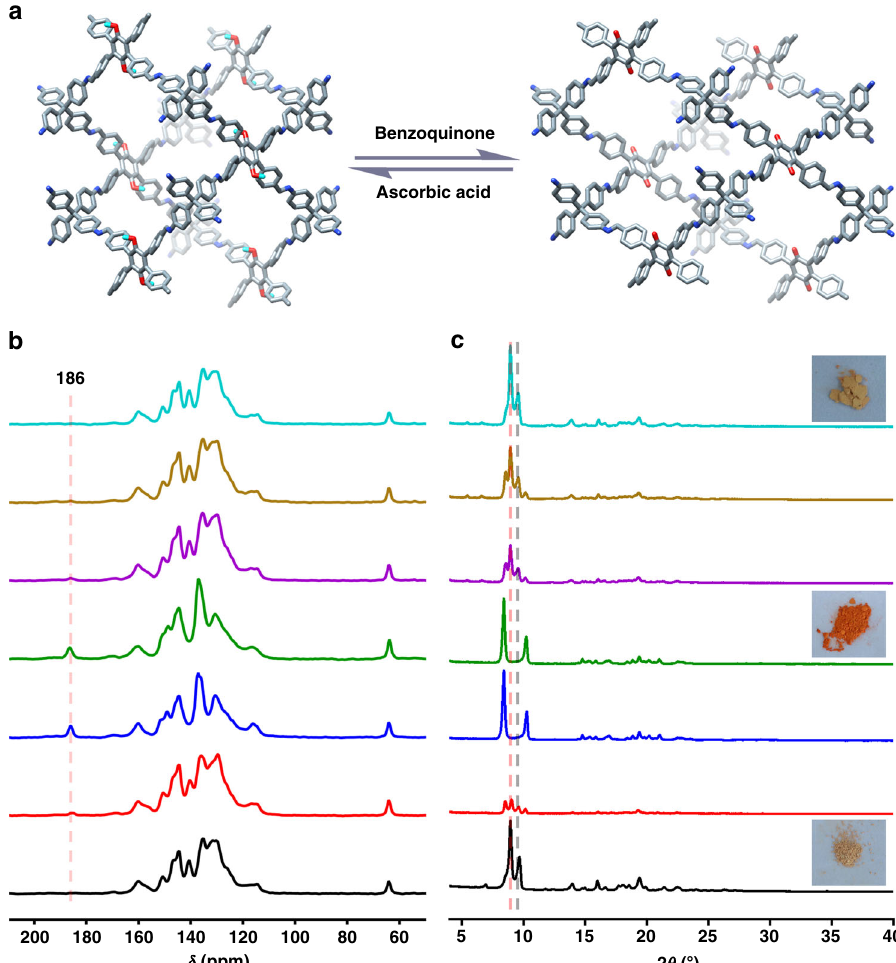
Fig. 4 Redox-triggered switching process. a Reversible crystal structures transformation between 3D-TPB-COF-HQ and 3D-TPB-COF-Q. b Solid-state 13 C NMR spectra of 3D-TPB-COF-HQ during the oxidation/reduction process. ( c ) PXRD patterns of 3D-TPB-COF-HQ during oxidation/reduction process. Note: 3D-TPB-COF-HQ (black line); oxidation for 2 min (red line); oxidation for 40 min (blue line); oxidation for 90 min (3D-TPB-COF-Q, green line); reduction for 30 min (dark violet line); reduction for 60 min (sienna line); reduction for 90 min (3D-TPB-COF-HQ (R), cyan line). Inset: the pictures of corresponding